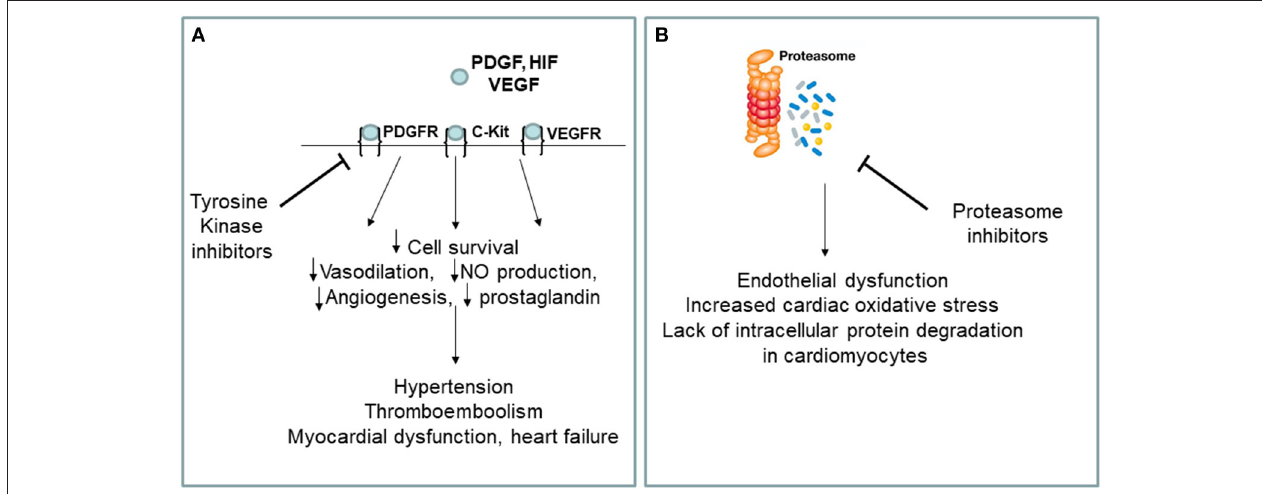
FIGURE 1 | (A,B) Putative mechanisms of cardiovascular toxicity induced by tyrosine kinase and proteasome inhibitors. VEGF, vascular endothelial growth factor, VEGFR, vascular endothelial growth factor receptor; PDGF, platelet derived growth factor; PDGFR, platelet derived growth factor receptor; HIF, hipoxia inducible factor; NO, nitric oxide; c-kit, stem cell factor